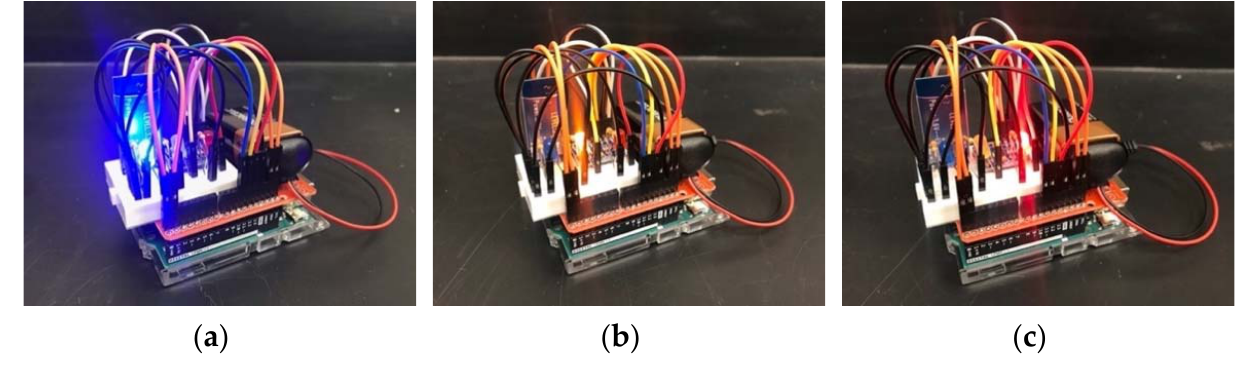
Figure 8. LED Subsystem with ( a ) Blue LED, ( b ) Yellow LED, and ( c ) Red LED. The LED subsystem serves as a visual representation of the k-means clustering algo- rithm and establishes feasibility for the failure detection system. We wrote a different code